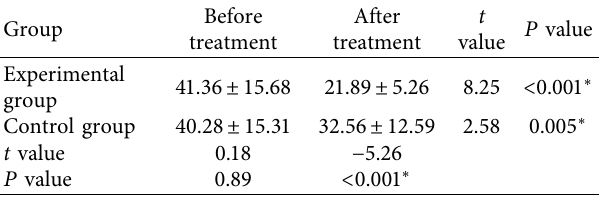
Table 4: Comparison of the scores of the SSPM scale between the experimental group and control group before and 8 weeks after treatment.